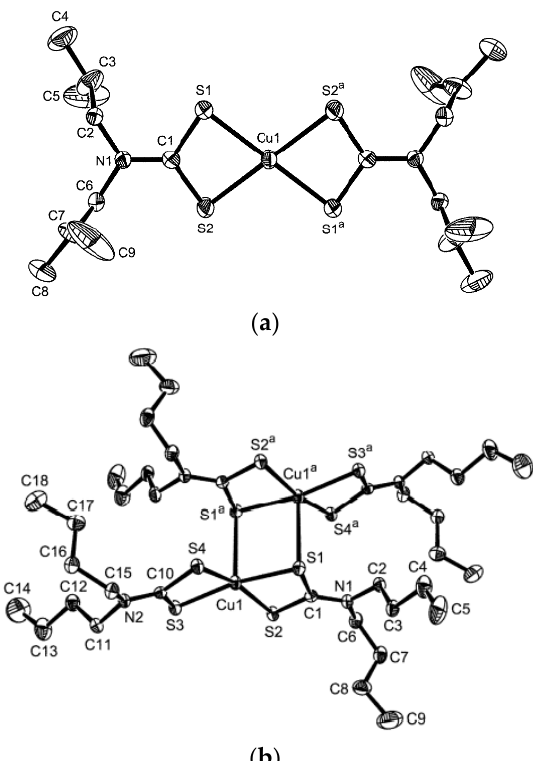
Figure 3. ( a ) Molecular structure of [Cu(S 2 CN i Bu 2 ) 2 ] as an example of a centrosymmetric monomeric complex, ( b ) molecular structure of [Cu(S 2 CN i Bu 2 ) 2 ] as an example of a dimeric complex in the solid state. Reproduced with permission from [7]. Copyright 2003